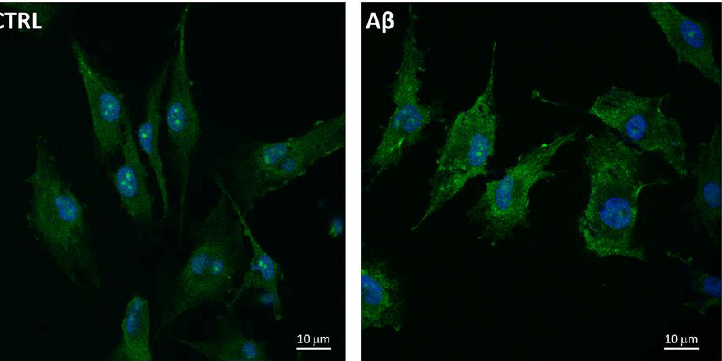
Figure 5. System X c − localization in A β 25-35 -treated U373. Cells were treated with A β 25-35 (50 µ M) for 24 h and subjected to immunofluorescence staining using anti-System X c − 1:100 (OriGene, green) antibodies as reported in Materials and Methods. Nuclei (blue) are stained with Hoechst 33342.